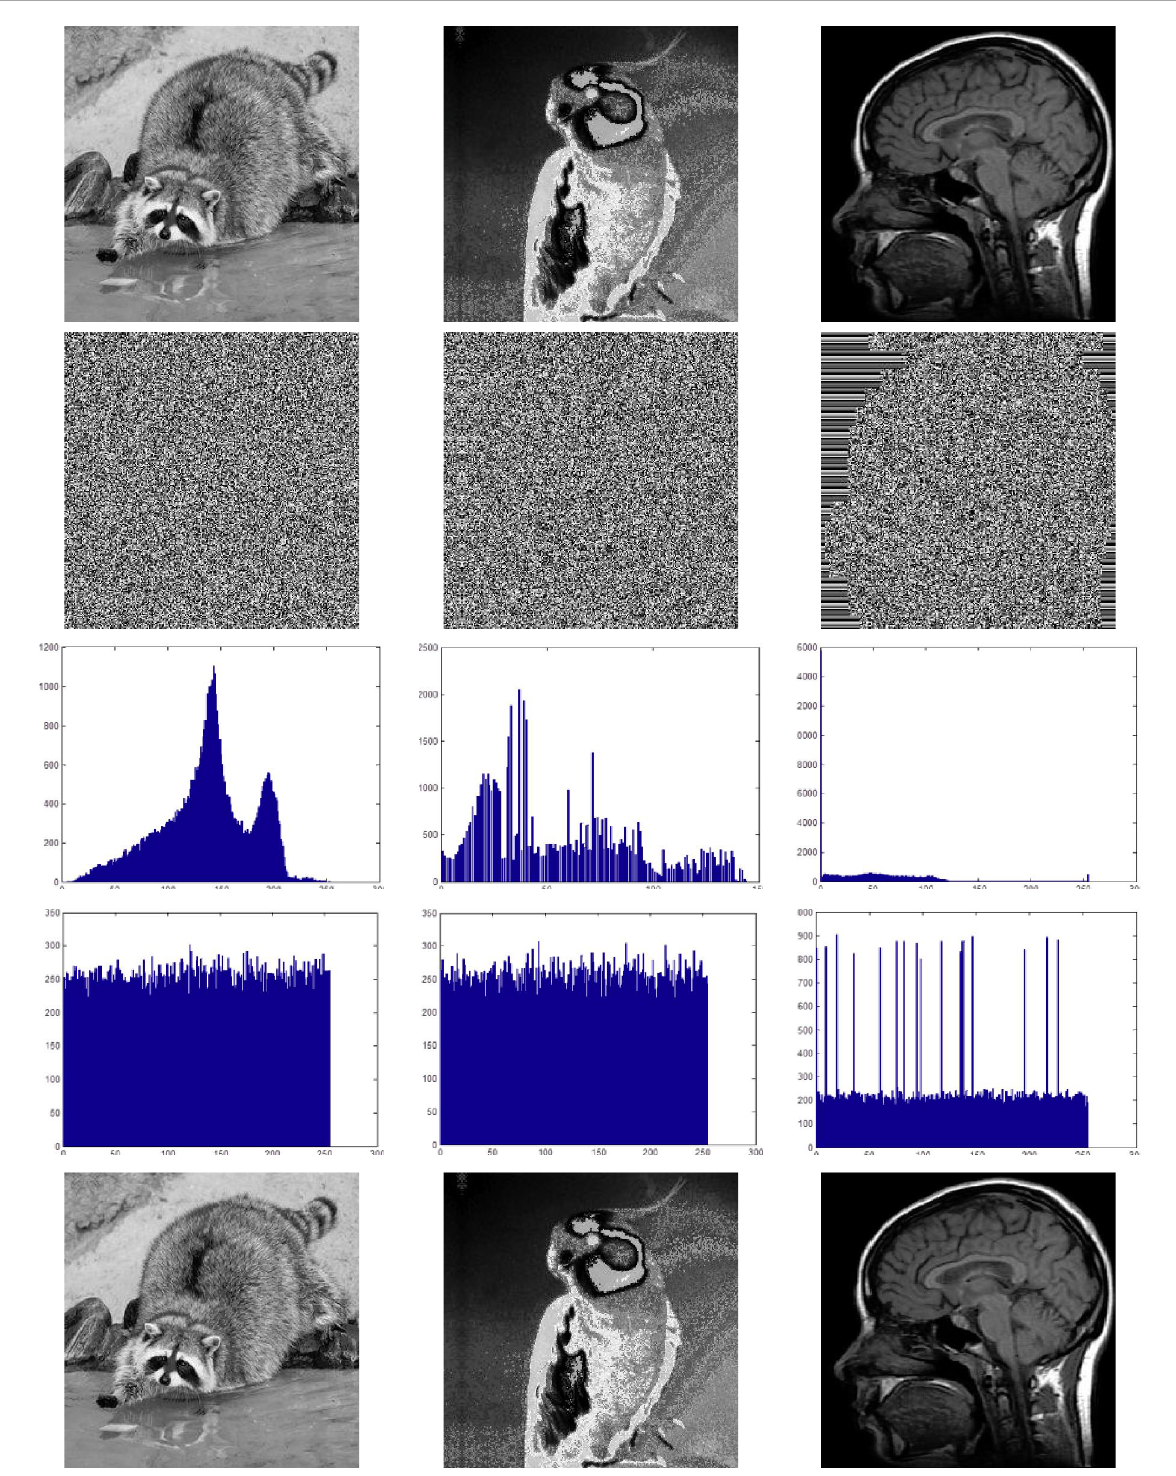
FIG. 5. ROW-1: ORIGINAL IMAGES: (I) RACCOON (II) PARROT (III) MRI SKULL, ROW-2: ENCRYPTED IMAGES, ROW-3: HISTOGRAMS OF ORIGINAL IMAGES, ROW-4: HISTOGRAMS OF ENCRYPTED IMAGES, ROW-5: DECRYPTED